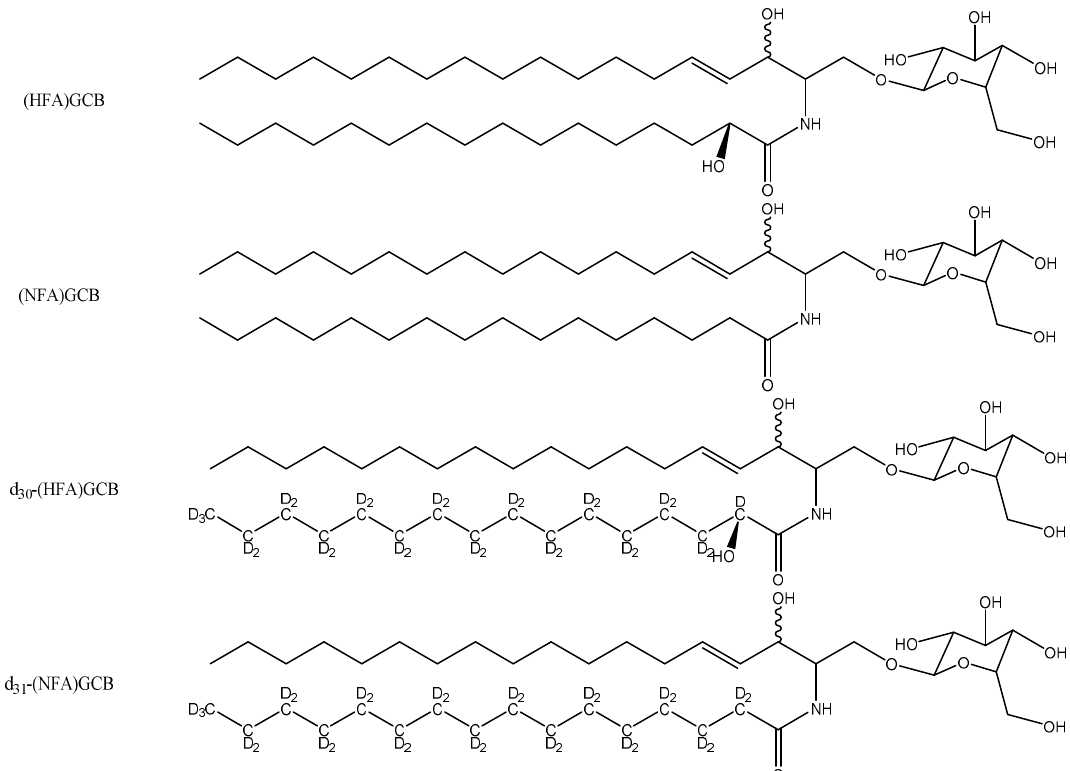
Figure 1. Molecular structures of the galactocerebroside (GCB) species employed; the deuterated GCB species were custom-synthesised for the present study.